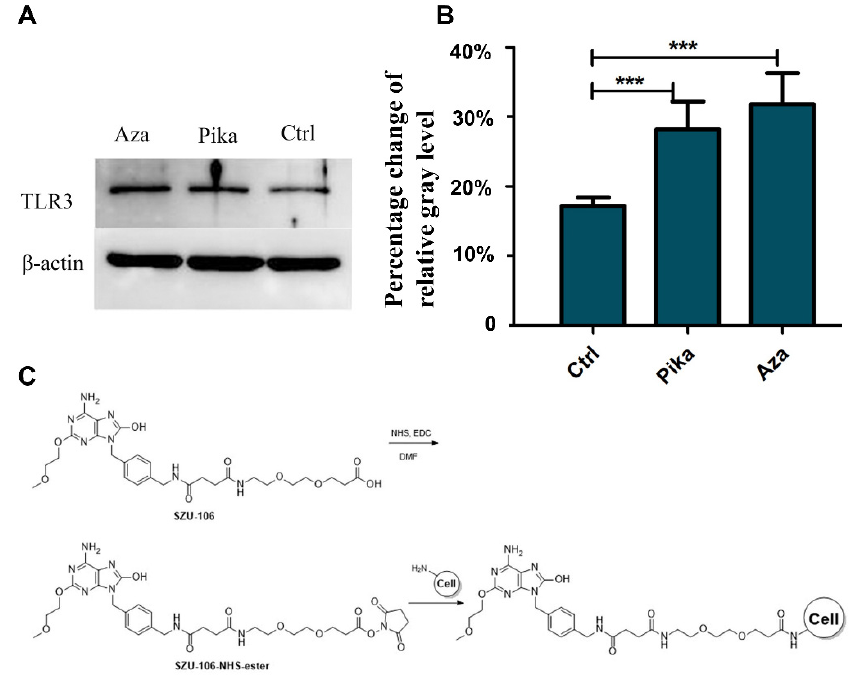
Figure 2. Design and preparation of the whole-tumor-cell vaccine. ( A , B ). Effect of Aza on the expression level of TLR3 in B16-F10 cells. ( A ) shows representative Western blots for TLR3 and the loading control ( β -actin) in each group. ( B ) is a bar graph showing the mean ± SD of the percentage change from control TLR3 expression. Data are expressed as the mean ± SD ( n = 3) of one representative experiment. The same results were obtained in three replicates. *** p < 0.001. ( C ). Scheme illustrating the conjugation of SZU-106 to mouse B16-F10 melanoma cells.